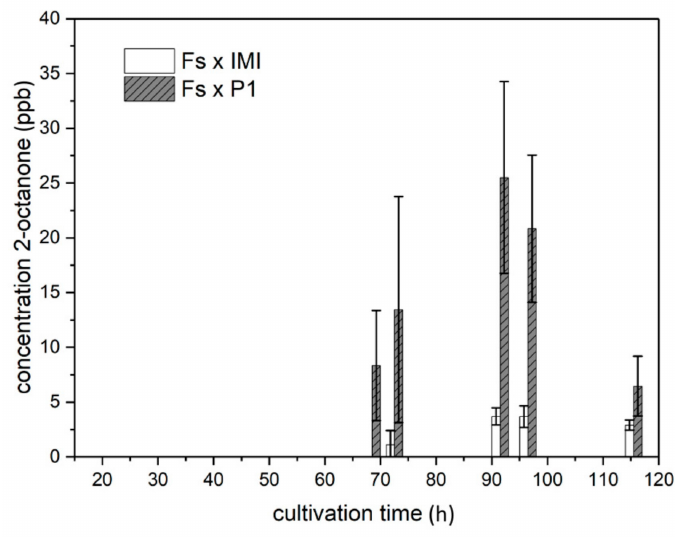
Figure 7. Exclusive, light-independent production of 2-octanone in direct confrontation of T. atroviride P1 and IMI 206040 with F. oxysporum . Levels (ppb) of 2-octanone detected in the headspace of co-cultures of T. atroviride P1 or IMI 206040 with F. oxysporum (Fo × P1; Fo × IMI) grown on PDA in Schott bottles at 25 ◦ C. GC–IMS measurements were conducted along a cultivation period of 120 h. As 2-octanone emission in co-culture reached similar levels under light-dark conditions and in complete darkness, results shown are means ± SD ( n =